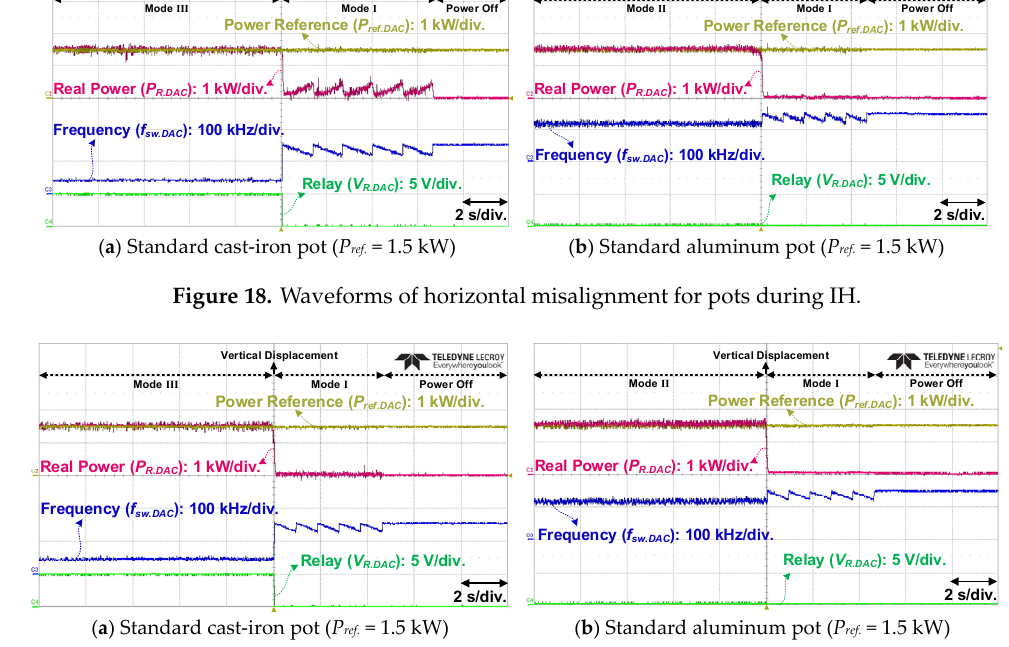
Figure 19. Waveforms of vertical displacement for pots during IH.